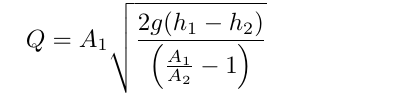
Figure 7: Control